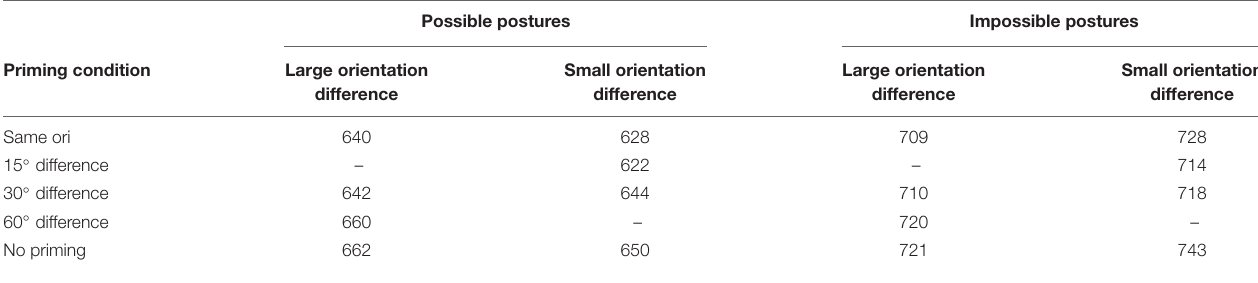
TABLE 3 | Mean identification time (in ms) of possible and impossible human postures in the test phase of Experiment 3 as a function of context condition (large vs. small orientation differences) and long-term priming condition (same orientation, 15, 30, or 60 ◦ difference, or no priming). Possible postures Impossible postures Priming